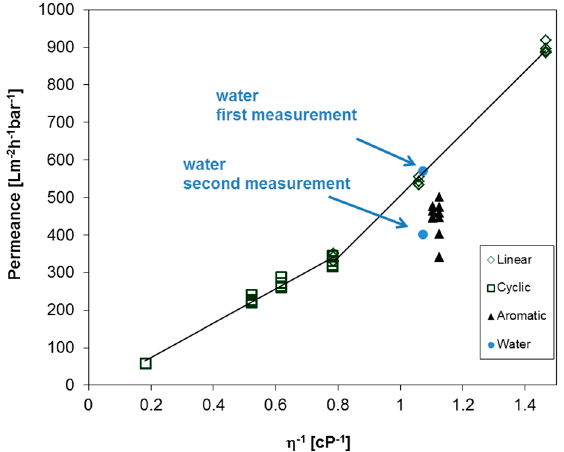
Figure 7. Permeances of BCPM made from PS 82.8 - b -P4VP 17.2190k against reciprocal viscosity of linear, cyclic, and aromatic PF compounds, respectively, and water. Each point represents the average value for one experiment with a liquid.